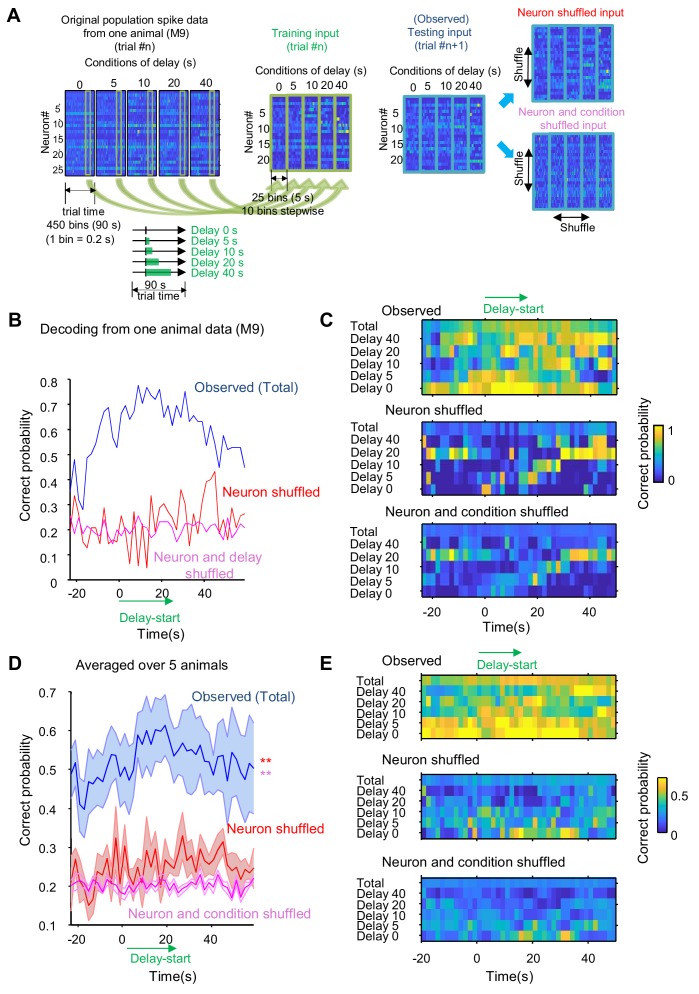
Decoding of delay length from population spike activity.(A) Schematic of the SVM decoding of delay length. Spiking trains of five delay conditions (0, 5, 10, 20 and 40 s) are transformed into normalized firing rates as training datasets. The population rate estimates are binned (200 ms) and those of 5 s (25 bins) were coupled and given in the multiclass models for SVM as training datasets. Testing datasets are produced with the spike activity of the next trial. Two control testing datasets are created by shuffling the labels of conditions and/or neurons. (B) Representative result of delay length decoding computed from the spike activity of 28 neuron from one animal (M9). The blue line indicates the probability of correct prediction (predicted from observed but untrained testing data). Red and magenta lines indicate the result of shuffled testing inputs (red: neuron shuffled; magenta: neuron and condition shuffled). (C) Color-coded correction rate map for the five delay conditions (0, 5, 10, 20 and 40 s) and total average. Top, result for observed inputs; middle, result for neuron-shuffled inputs; bottom, result for neuron- and condition-shuffled inputs. (D) Averaged decoding results from population spikes of five animals (M9, 28 neurons; M10, 43 neurons; M17, 22 neurons; M25, 34 neurons; and M27, 23 neurons). Data are shown as mean ± SEM. Red **: observed vs neuron shuffled, p<0.001; magenta **, observed vs neuron and condition shuffled, p<0.001; group effect, F2=882.1, p<0.001, two-way ANOVA. (E) The decoding results of individual delay length. Color-coded rate maps for the five delay conditions (0, 5, 10, 20 and 40 s) and total average. Top, result for observed inputs; middle, result for neuron-shuffled inputs; bottom, result for neuron- and condition-shuffled inputs. Data from five mouse were used.